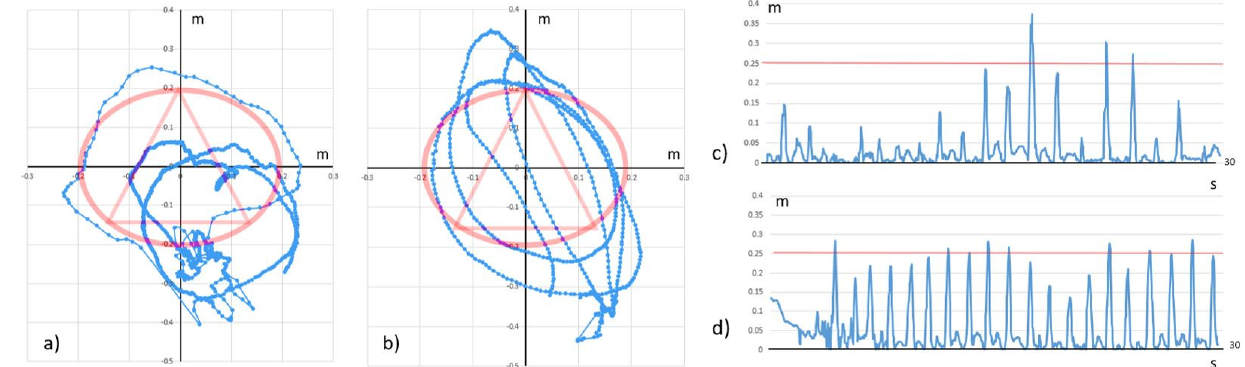
Figure 3. Trajectory of movement during AR rehabilitation on 1st and 10th days (Patient from A group example): ( a ) 1st session. Trajectory of movement on X and Y coordinates of forefinger on left hand during the Static domain execution: red line is given trajectory, blue line is real trajectory of forefinger; ( b ) 10th session. Trajectory of movement on X and Y coordinates of forefinger on left hand during the Static domain execution: red line is given trajectory, blue line is real trajectory of forefinger; ( c ) 1st session. Height of raising the left foot during the Balance domain execution: red line is height of virtual obstacle, blue line is Y coordinate of left foot; ( d ) 10th session. Height of raising the left foot during Balance domain execution: red line is height of virtual obstacle, blue line is Y coordinate of left foot.